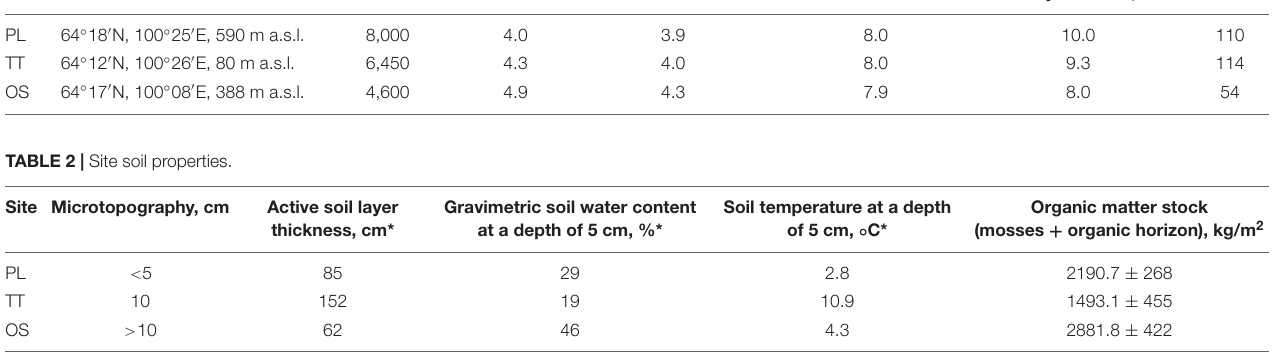
Mean tree trees/ha height, m